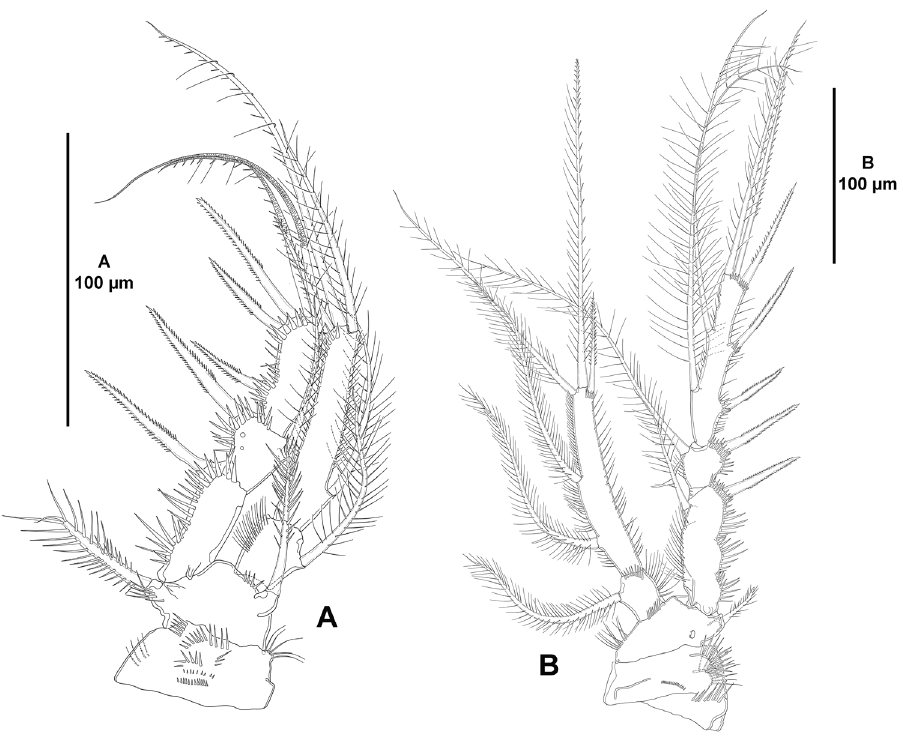
Figure 6. Eurycletodes paraephippiger sp. n., female holotype. A P1, anterior B P2,